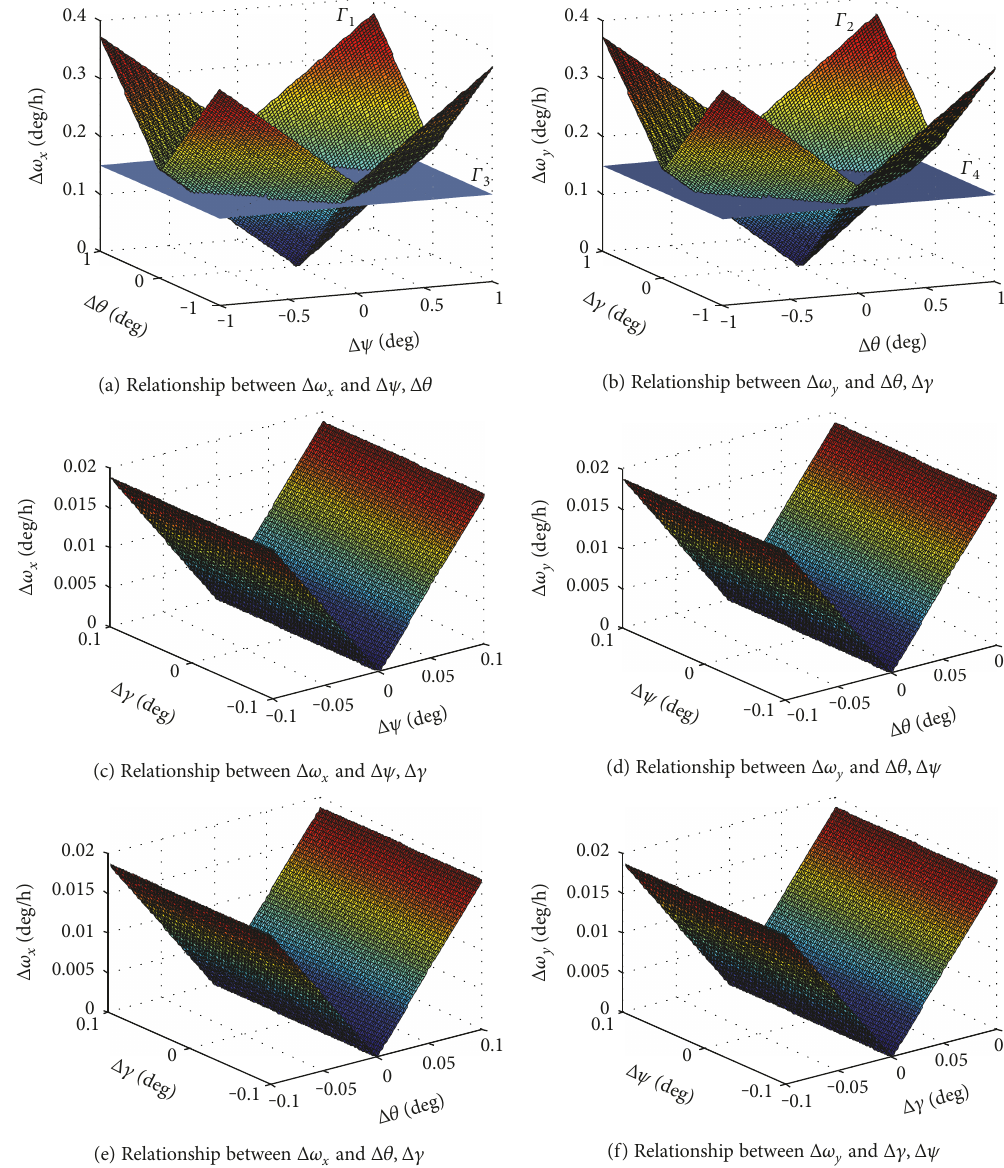
Figure 4: Relationships between rate-sensing errors and orientation